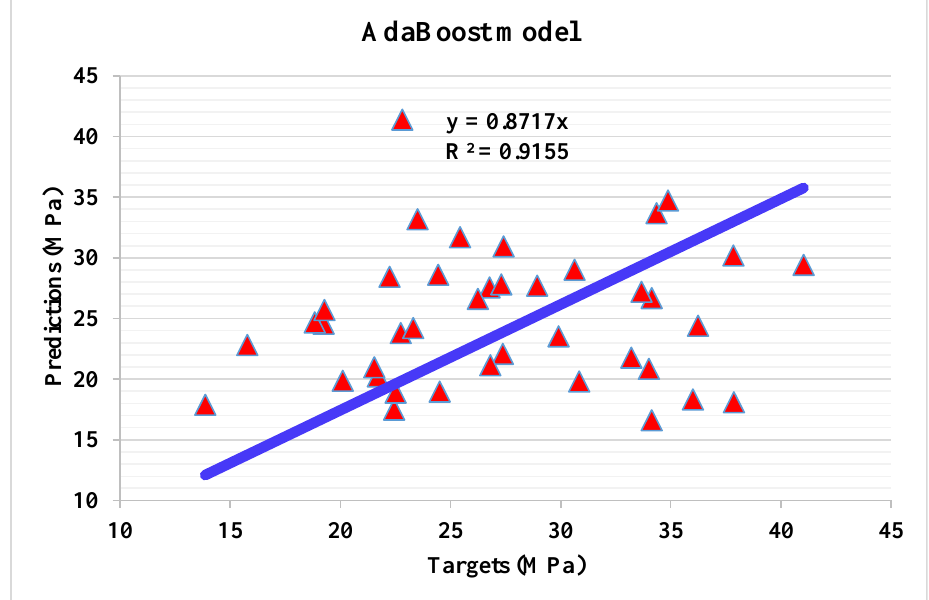
Figure 14. Predicted and actual results for AdaBoost model.